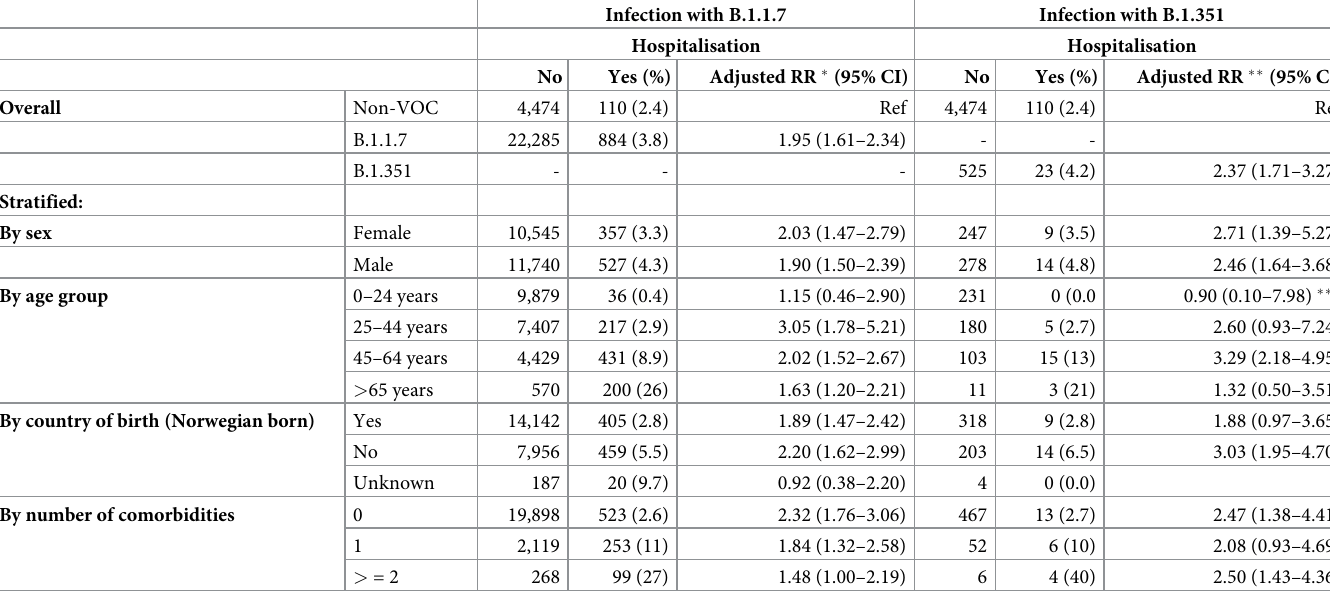
Table 2. Association between hospitalisation and infection with B.1.1.7 and B.1.351 compared to non-VOC of SARS-CoV-2 (adjusted for demographic characteris- tics and number of comorbidities) overall and stratified by sex, age groups, country of origin, and number of comorbidities, Norway, December 2020—May